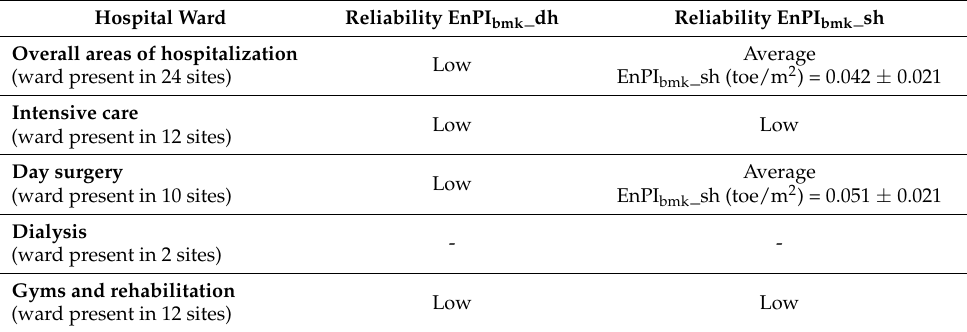
Table 3. Reliability evaluation for the EnPIs related to